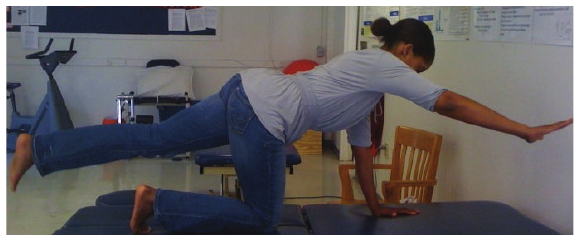
Figure 3: End positioning for the quadruped exercise.